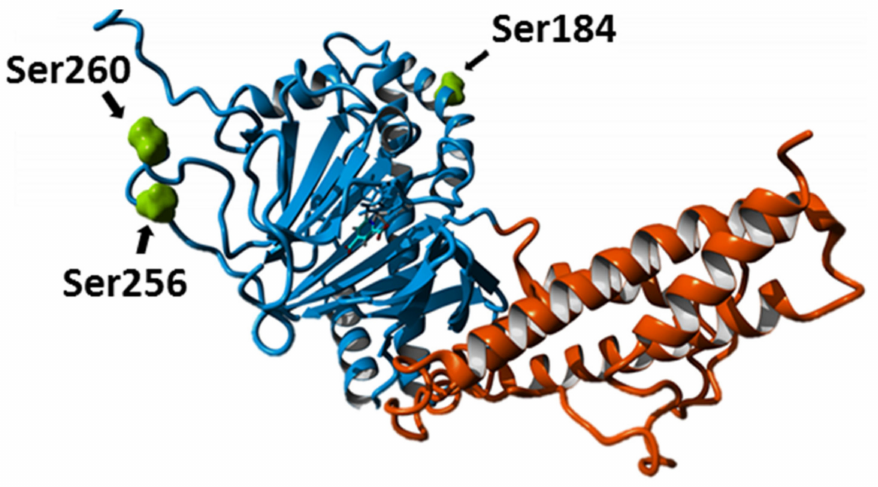
Figure 3. Location of phosphoserines identified in BES FTO. The modifications (green) are located only in the N-terminal domain (blue); the C-terminal domain is in orange. The FTO protein structure was modelled basing on the PDB4IE5